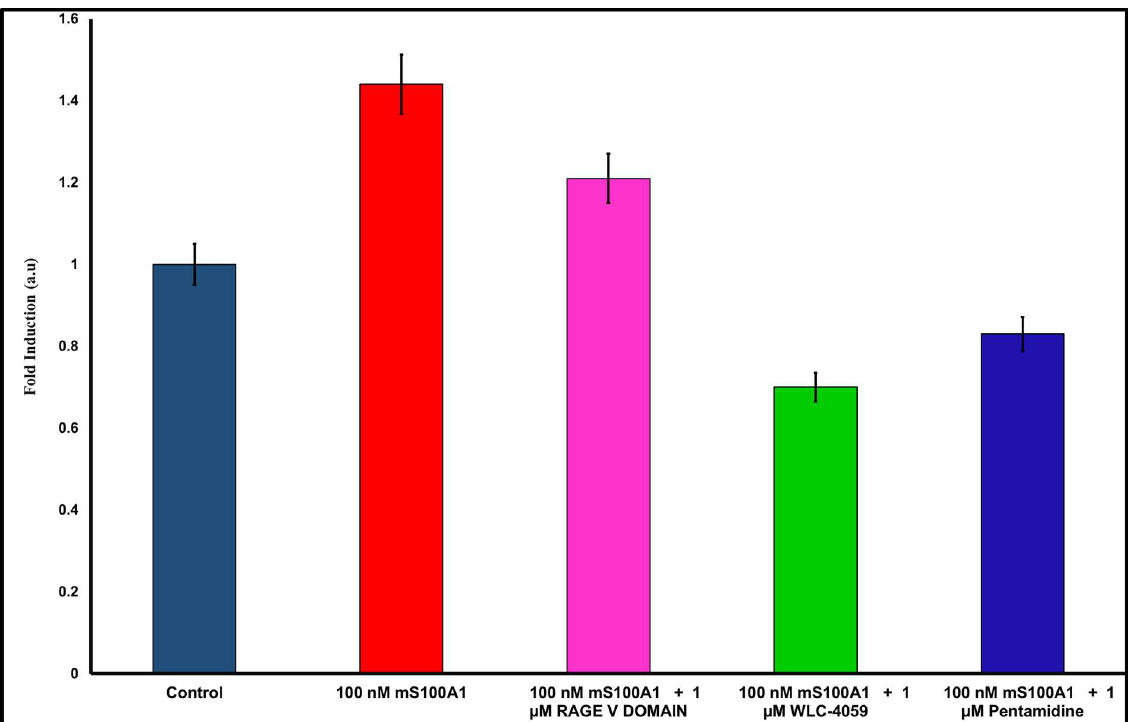
Figure 5. WST1 assay results for S100A1 with RAGE V domain, pentamidine, and pentamidine derivative. Control is in blue, 100 nM S100A1 is in red, 100 nM S100A1 with 1 µM of RAGE V domain is in pink, 100 nM S100A1 with 1 µM of WLC-4059 is in green and 100 nM S100A1 with 1 µM of pentamidine is in navy blue.